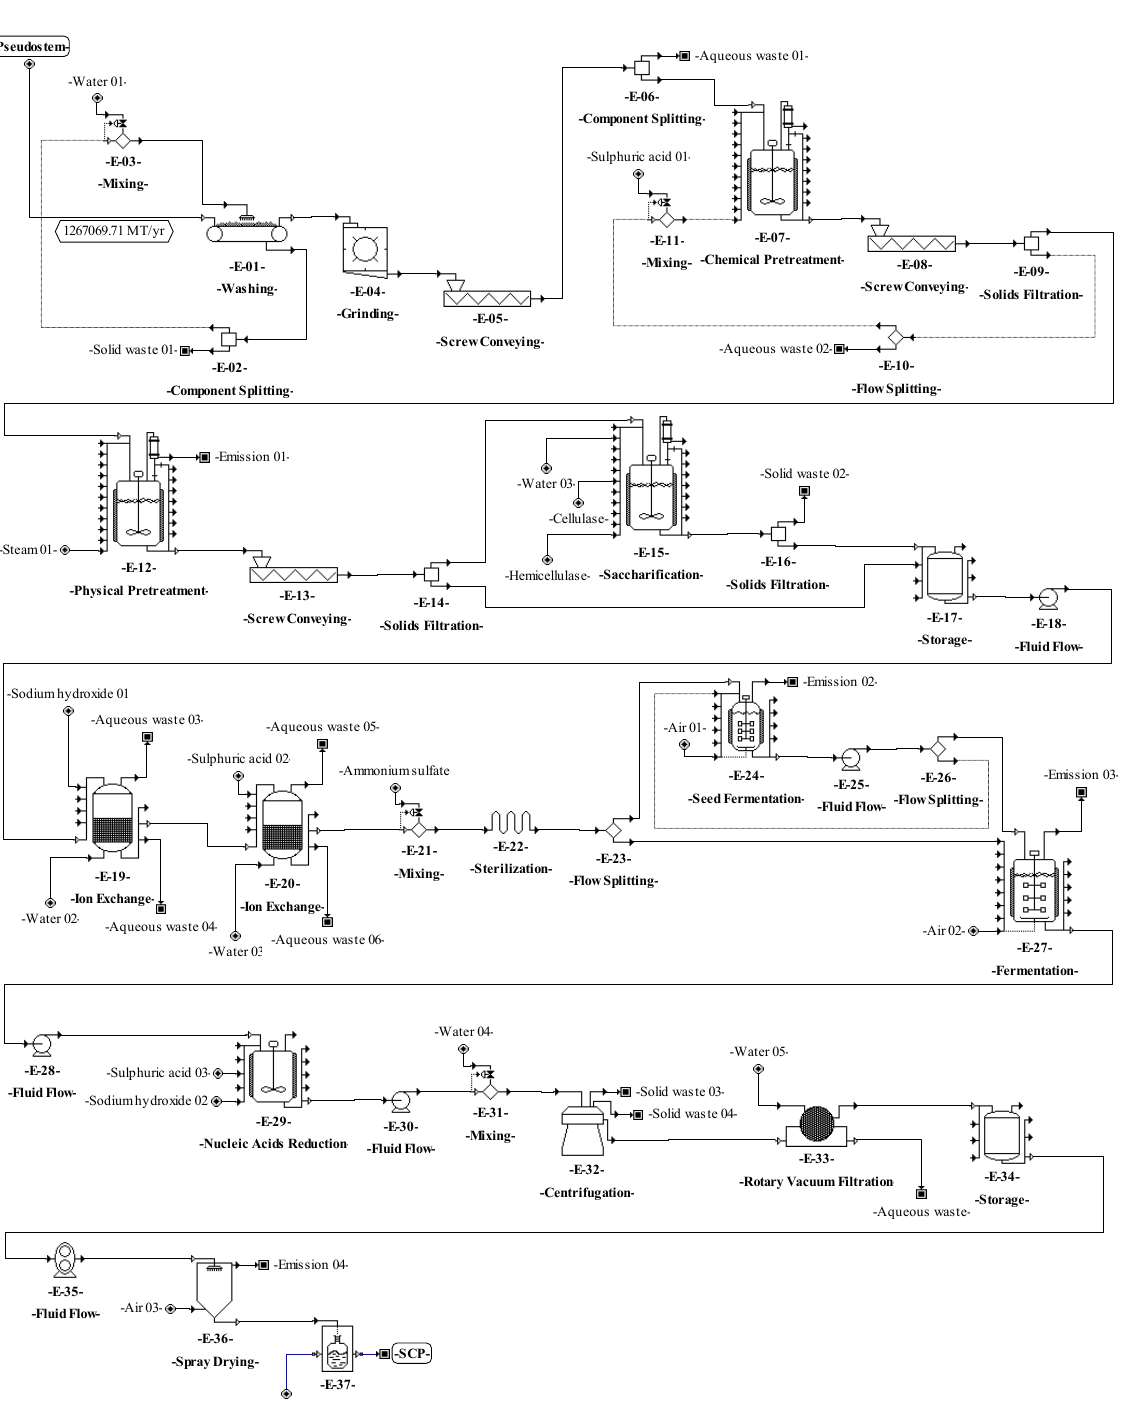
E-21, E-24, E-26, and E-31) and for balance storage (E-08, and E-30) were included as well (Figure 5). For NF production, some units for transferring solids (E-03, E-10, and E-13) were added (Figure 6). Finally, for BM production, equipment units to transfer solids (E-02, E-04, and E-15) and liquids (E-06 and E-24), and for balance storage (E-05) were defined and added (Figure 7). The inclusion of these unit procedures allowed an assessment of their impact on the techno-economic index.